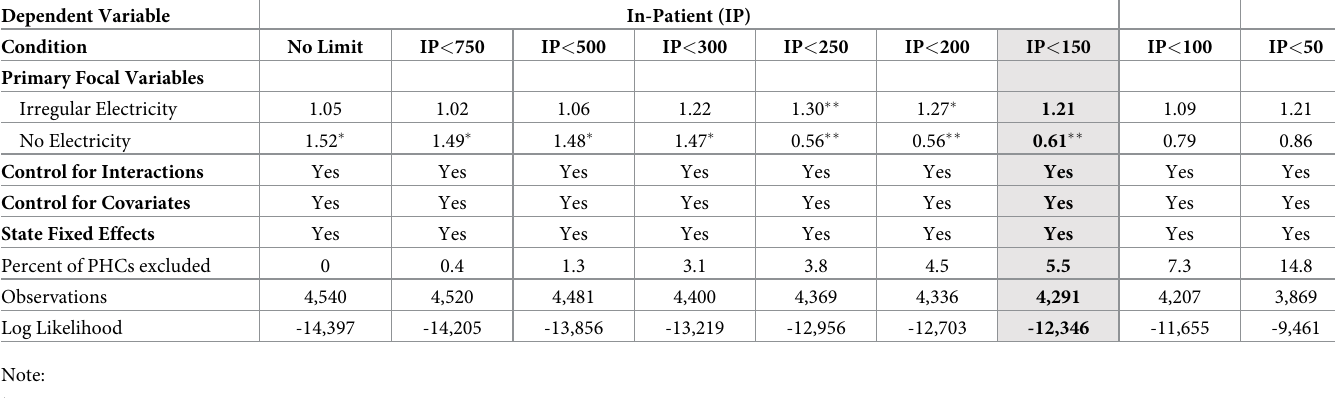
Table 4. Sensitivity analysis—Incidence Rate Ratios (IRR) (exponentiated log-odds) for the focal variables in the regression models for In-Patient outcome variable, under different outlier threshold